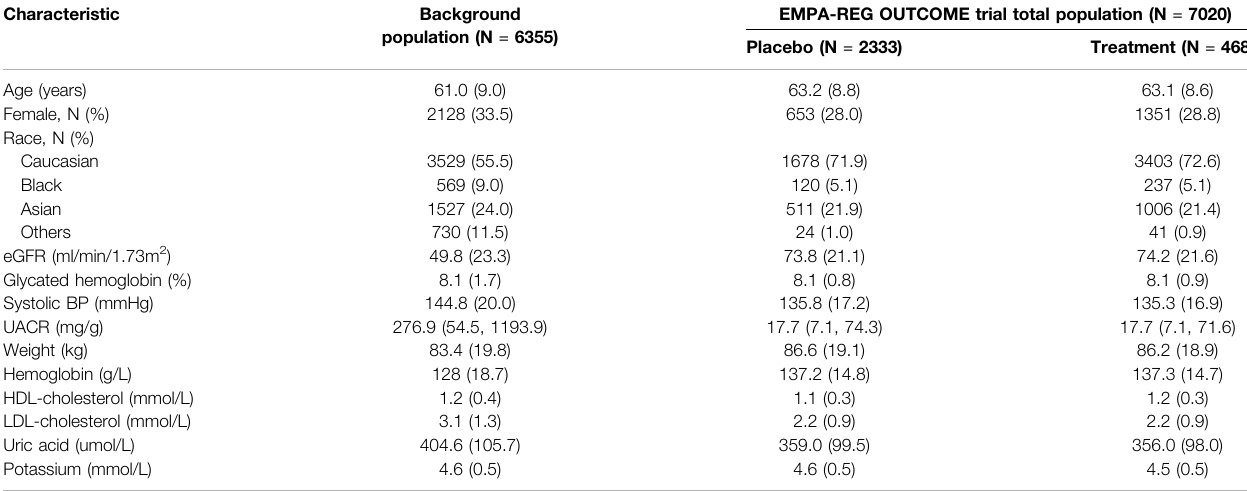
TABLE 1 | Baseline characteristics of patients included in the background population and the EMPA-REG OUTCOME trial. Characteristic